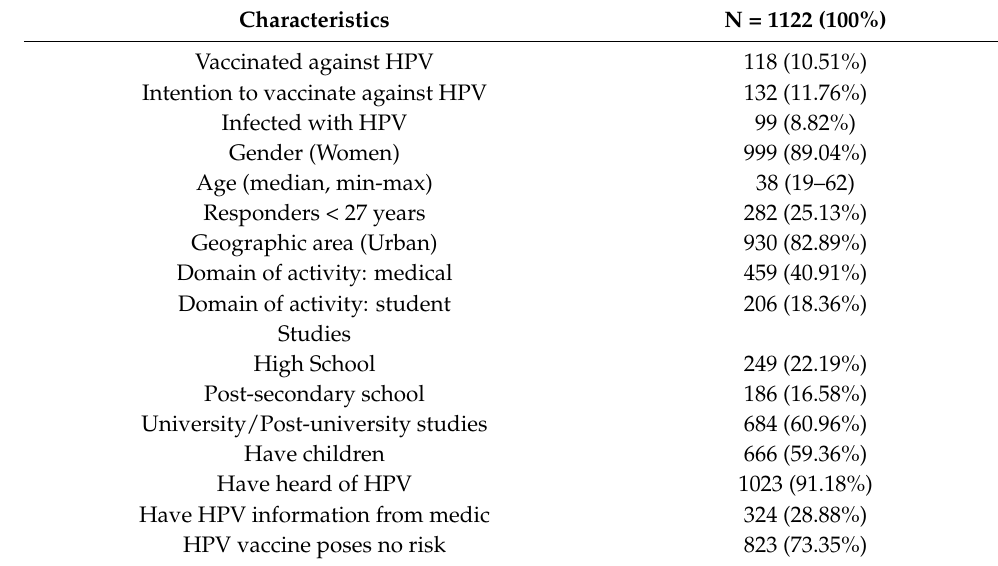
Table 1. Vaccination/infectious HPV status, socio-demographic, and educational characteristics of respondents to the questionnaire. HPV awareness.